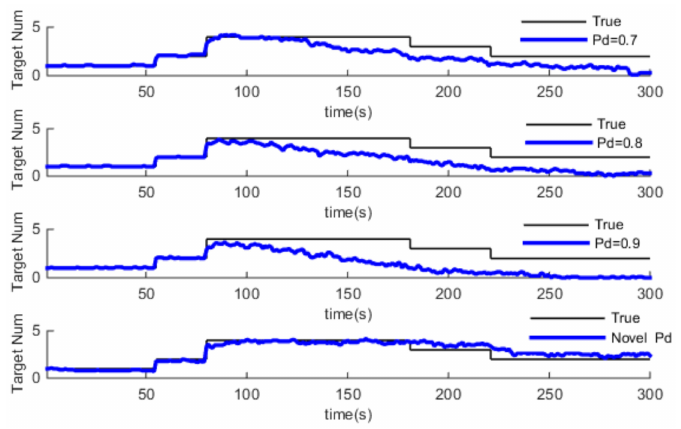
Figure 9. Comparison of target number estimation with different P d in clutter intensity κ k =